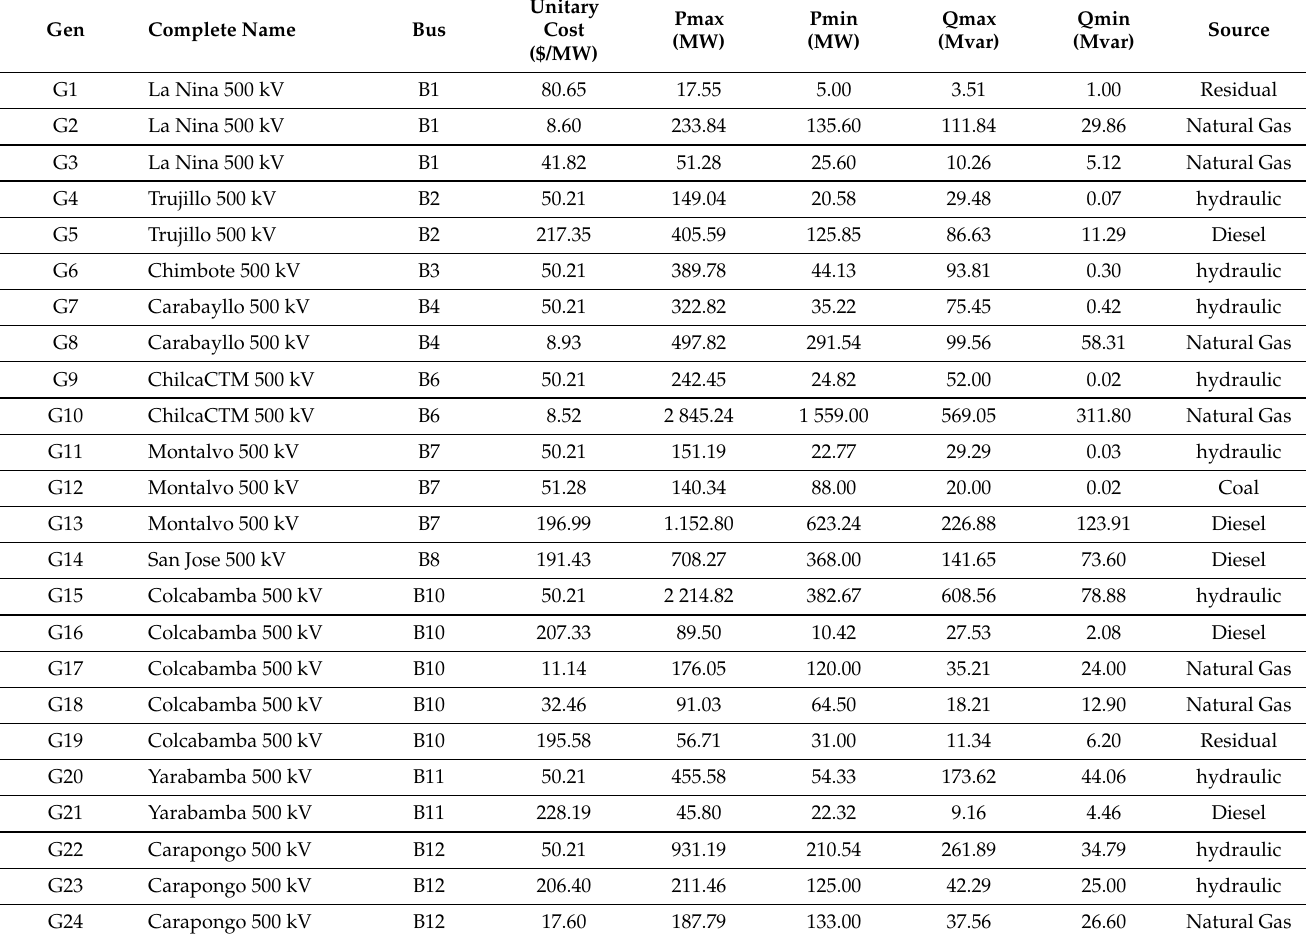
Table 2. Generator data of the equivalent model in 500 kV of the